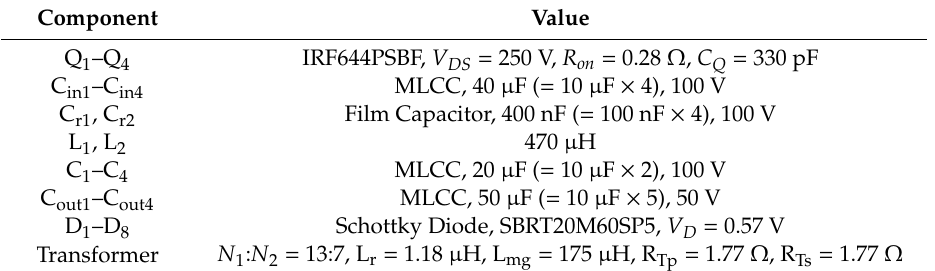
Table 1. Circuit components used for